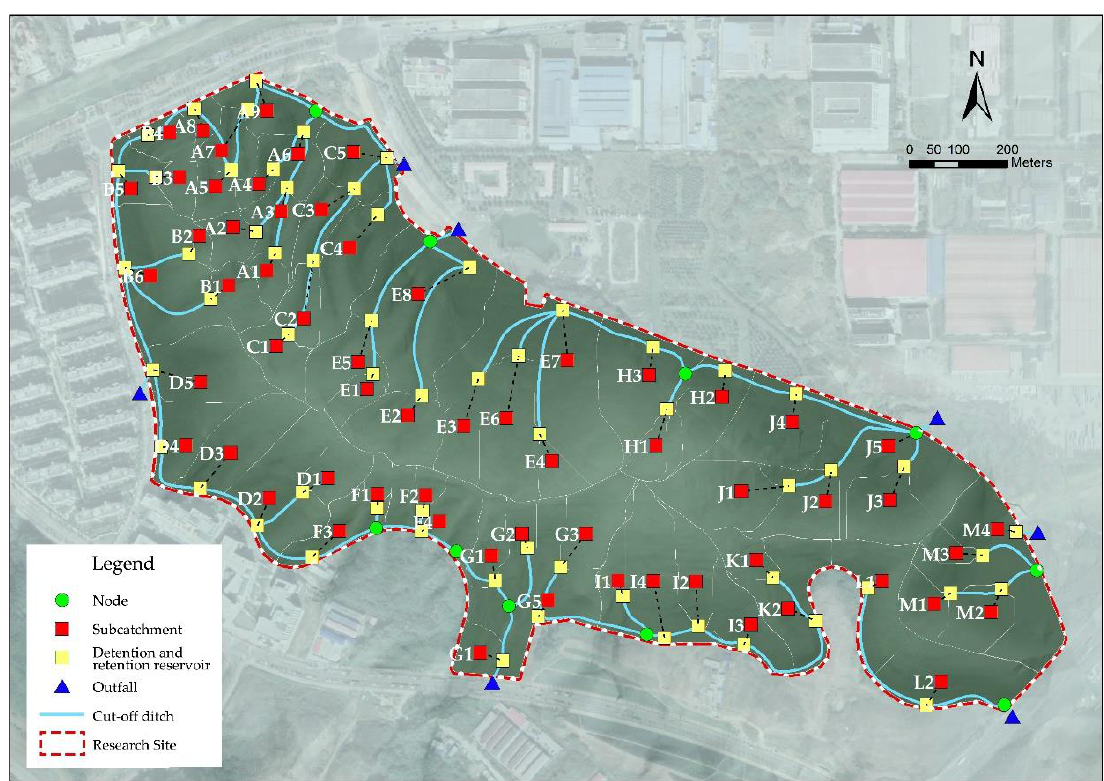
Figure 6. Division of Scheme S’s sub-catchments and layout of detention and retention wetlands.